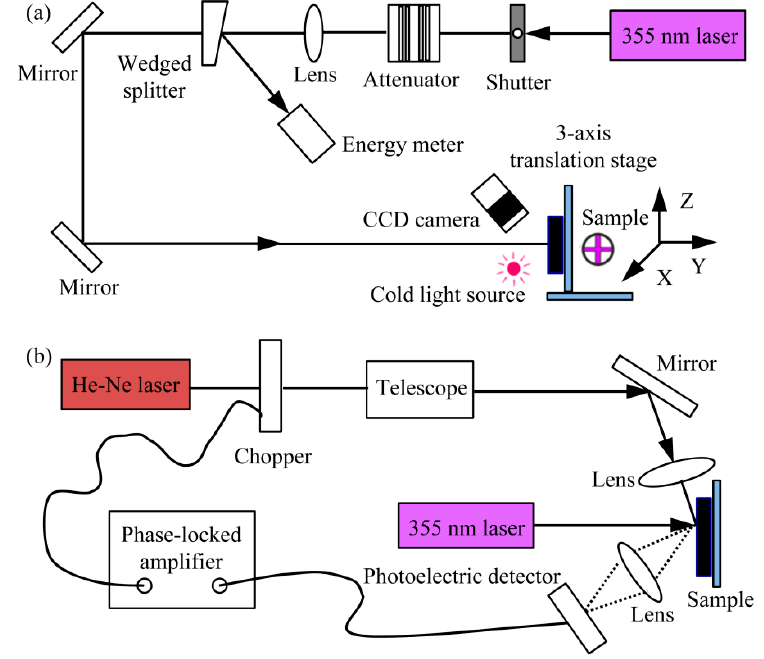
Figure 4. Schematic diagram of the laser path designed for the laser damage experiments ( a ) and the online monitoring system; ( b ) applied for detecting the laser damage initiation.